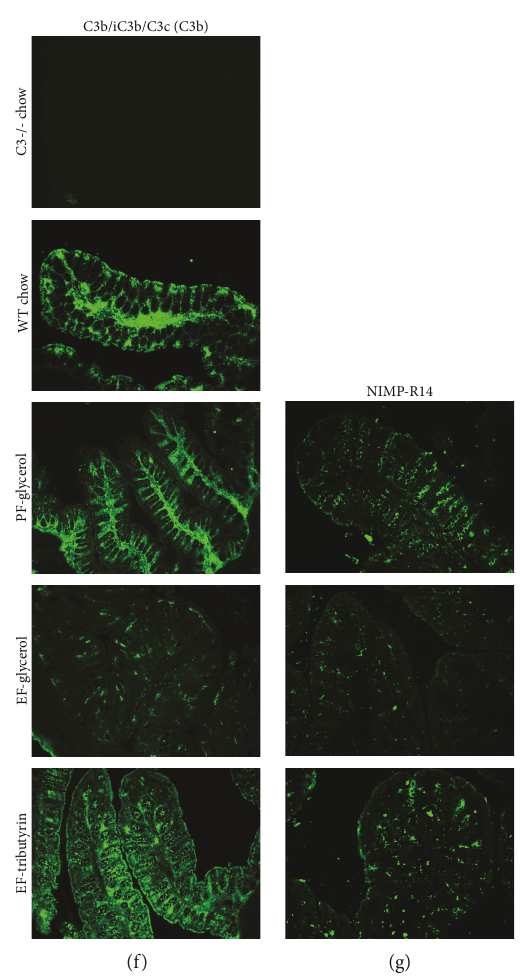
Figure 1: E ff ects of tributyrin on presence of immune cells in proximal colon following chronic-binge ethanol exposure. Mice were fed an ethanol-containing (5% v / v ) liquid diet or pair-fed a diet with maltose-dextrin isocalorically substituted for ethanol for 10 days. Diets were supplemented with glycerol or tributyrin (5 mM). Mice were then treated with a single 5g/kg gavage of ethanol the next day containing glycerol or tributyrin (2.5 mM). At 9h post-gavage, the proximal colon was collected and used to prepare RNA or embedded in optimal cutting temperature compound (OCT) for histology. (a) CD45 (green), (b) CD68 (green), (f) C3b/iC3b/C3c, and (g) NIMP-R14 were visualized by immunohistochemistry in sections of proximal colon frozen in OCT. Images were acquired using a 10x or 20x objective. A selected area was cropped and enlarged. (c – e) Expression of CD68, Ly6c, and ELANE mRNA was detected in the proximal colon using quantitative real-time reverse transcription polymerase chain reaction. (f) In addition to pair-fed and ethanol-treated mice, proximal colon frozen in OCT from age- and gender-matched C57BL/6 and C3 − / − mice on a C57BL/6 background were stained for expression of C3b/iC3b/C3c. C3b-positive staining was visualized in wild-type mice similarly to that of pair-fed mice, and, as expected, C3 − / − were negative for positive C3b staining. Images are representative of at least replicate images captured per mouse in four to six mice per treatment group. Data are mean ± standard error of the mean (SEM). Values with di ff erent alphabetical superscripts were signi fi cantly di ff erent from each other; p < 0 05 and ∗ p < 0 05